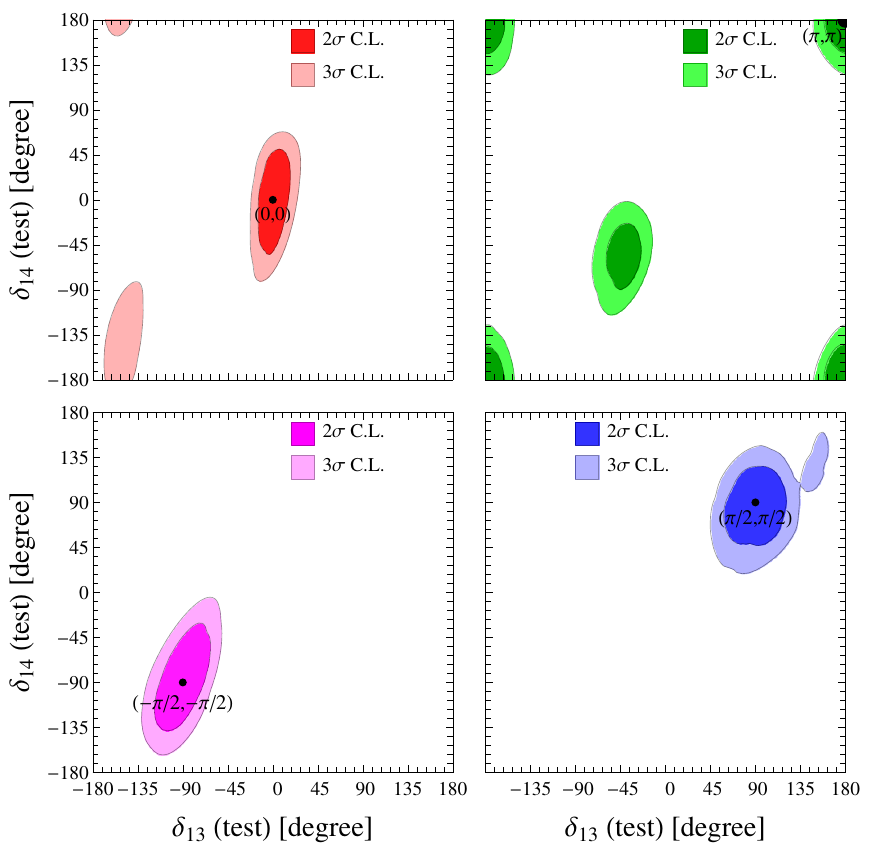
Figure 7 . Reconstructed regions for the two CP phases (cid:14) 13 and (cid:14) 14 for the four benchmark pairs of their true values indicated in each panel. We have taken the NH as the true hierarchy and we have marginalized over the two possible hierarchies in the test model. The contours refer to 2 (cid:27) and 3 (cid:27)